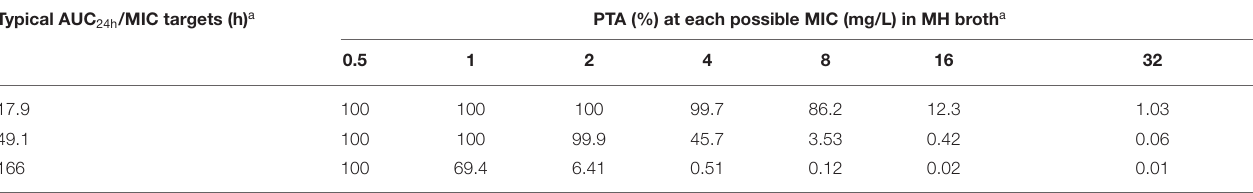
TABLE 3 | Probability of attaining the typical area under the concentration (AUC 24h )/MIC targets at each possible MIC value when treated with gamithromycin at the current dose of 6.0 mg/kg against S. suis infections. Typical AUC 24h /MIC targets (h) a PTA (%) at each possible MIC (mg/L) in MH broth